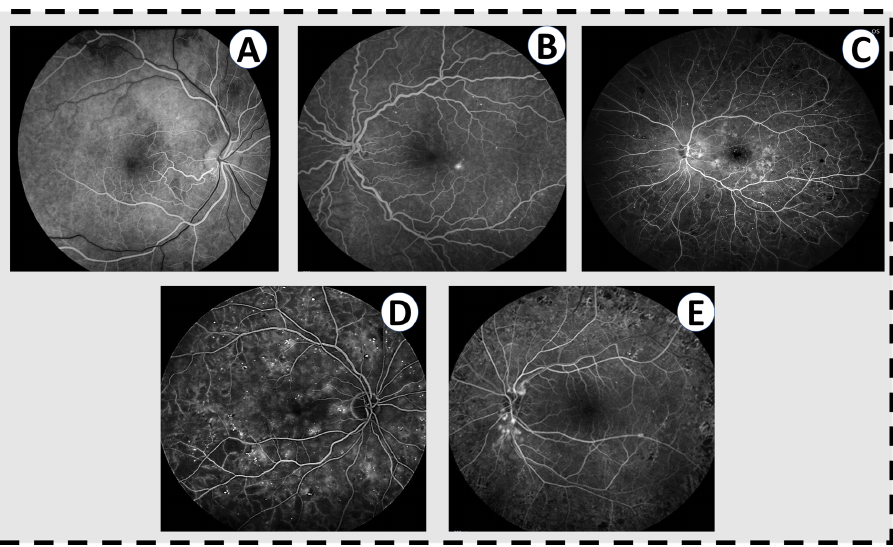
Figure 2. Fluorescien angiograms for varying levels of DR. ( A ) A normal angiogram in the early phase, where the arteries have filled with fluorescein dye but the veins have not. There is nothing in this eye. ( B ) Mild nonproliferative DR with a few scattered microaneuryms and a single pinpoint area of leakage inferotemporal to the fovea. ( C ) Moderate nonproliferative DR with multiple microa- neurysms throughout the fundus, significant leakage of dye throughout the macula, and blockage in the periphery from intraretinal hemorrhages. ( D ) Severe nonproliferative DR with abundant mi- croaneurysms and dark areas on the angiogram corresponding to capillary non-perfusion. ( E ) Active proliferative DR with leakage from the optic disc from neovascularization. The retinopathy has been treated with laser (dark spots in the periphery) but there remains some level of neovascular